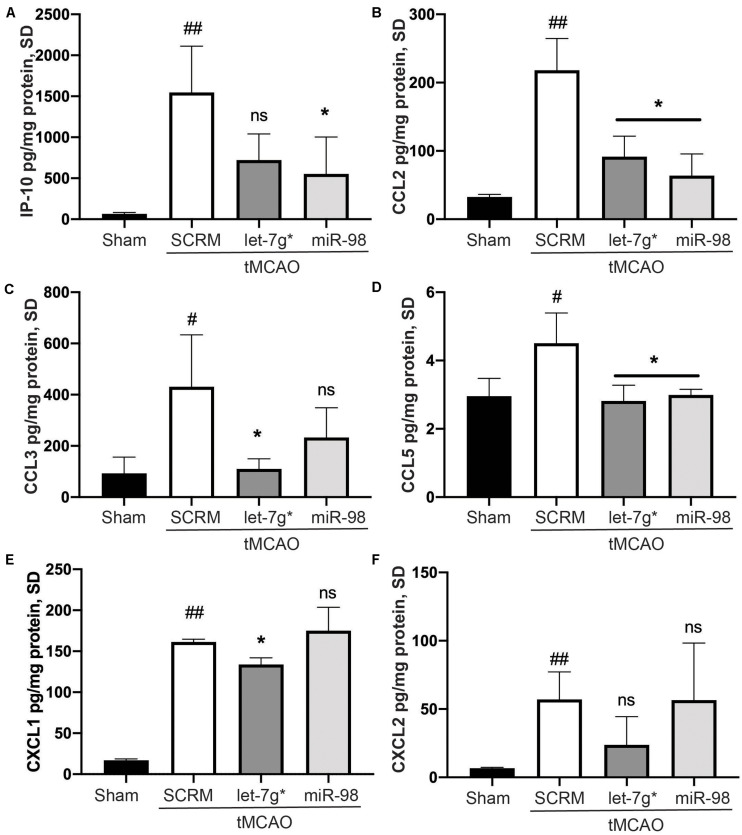
Let-7 miRs differentially reduce cytokine release following stroke. ELISA analysis of IP-10 (A), CCL2 (B), CCL3 (C), CCL5 (D), CXCL2 (E), and KC/GRO (CXCL-1 mouse analog) (F) expression. Mice were subjected to 60 min ischemia and 72 h reperfusion performed as described in section “Materials and Methods.” Brains were harvested following anesthesia, homogenized, and were used to run all assays. Results are presented as mean ± SD from at least two independent experiments (n = 4). #p < 0.05 (SCRM); *p < 0.05 (let-7g*, miR-98). ##p < 0.01 (SCRM); ns is not significant.